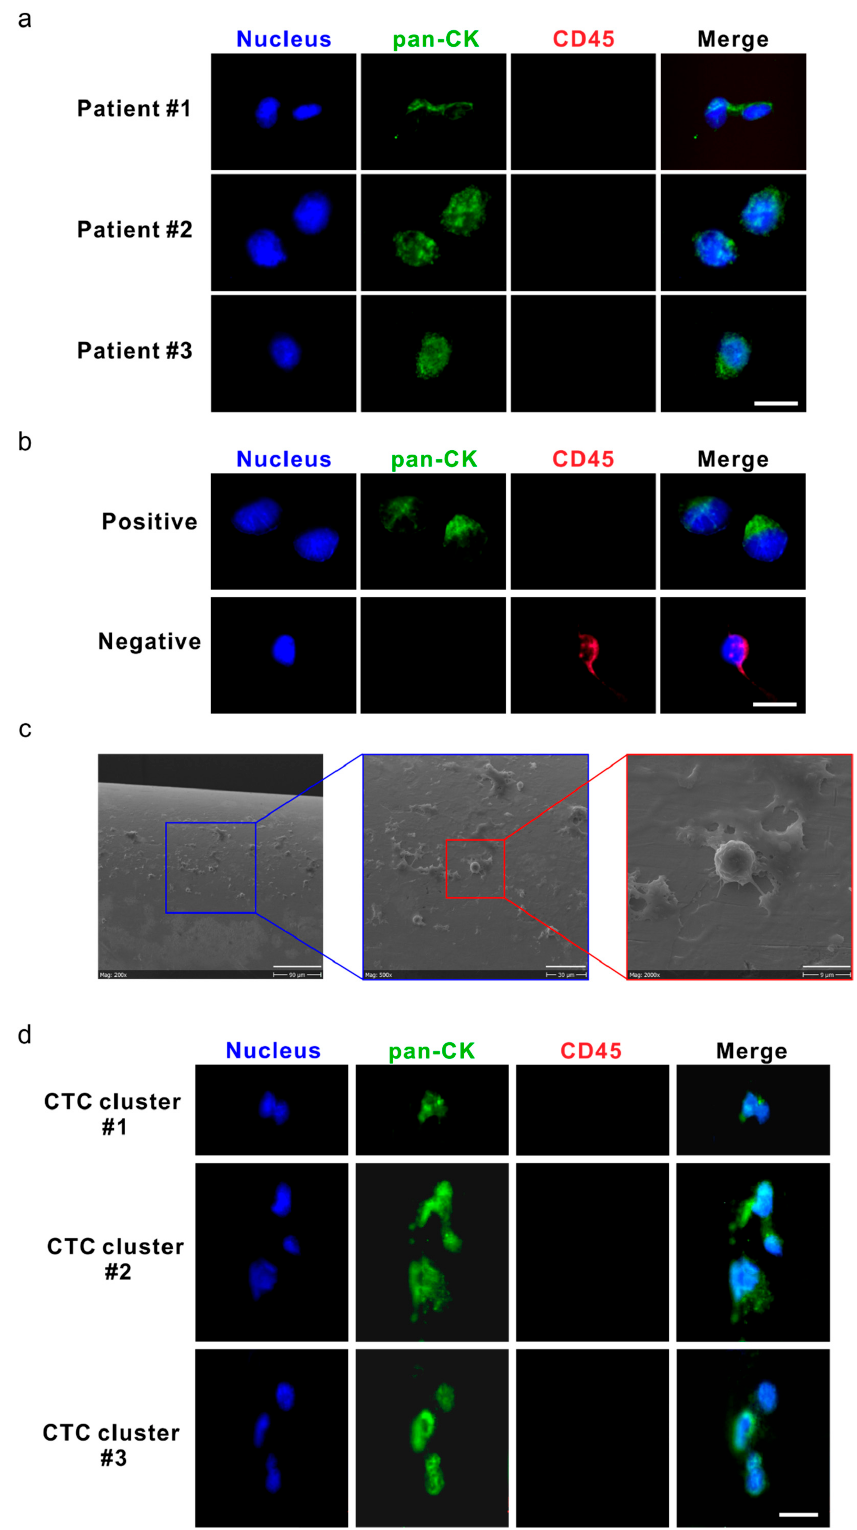
Figure 3. Circulating tumor cells (CTCs) and CTC clusters were detected by the DC01 device in patients with high-risk non-metastatic prostate cancer (PCa). ( a ) Micrographs of five CTCs on the DC01 detected from three patients; CTCs were defined as being positive for nucleic staining and pan-CK (pan-cytokeratin), and negative for CD45 by immunofluorescence staining (DNA (blue) and pan-CK (green)). Scale bar: 20 µ m. ( b ) Images of control samples for CTC staining panel, upper panel: